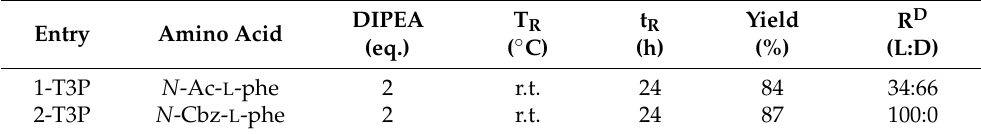
Table 3. T3P coupling specifics for the synthesis of L-2a or L-4c . T R = reaction temperature, t R = reaction time, R D = L : D